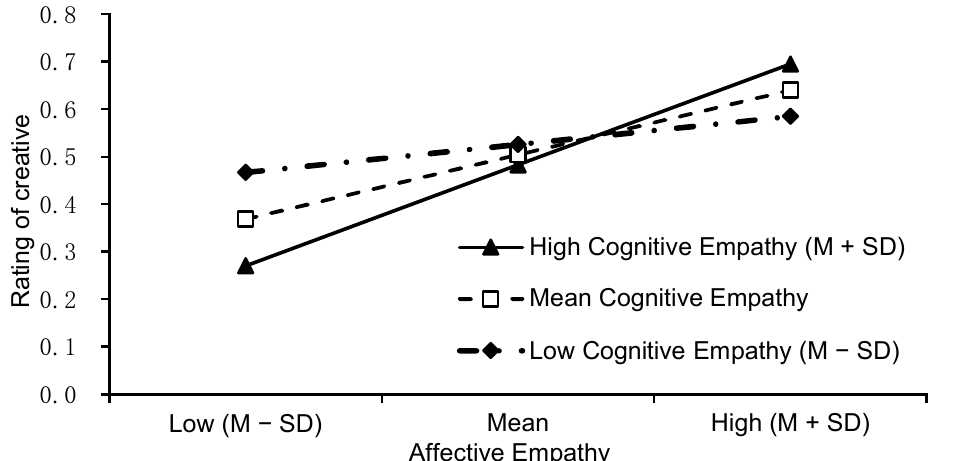
Figure 5. The simple slope of affective empathy in different cognitive empathy levels for the advan- taged condition.